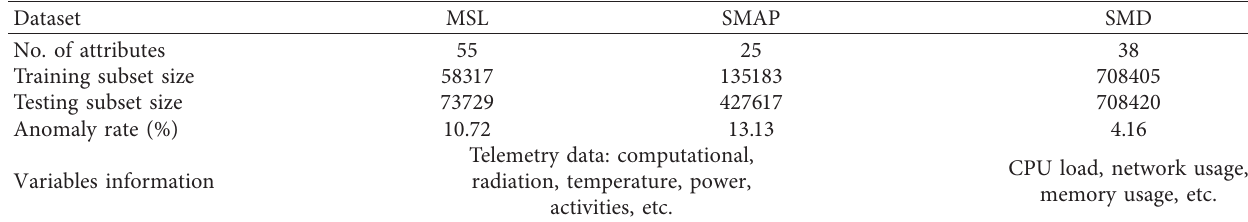
Table 1: Dataset information.